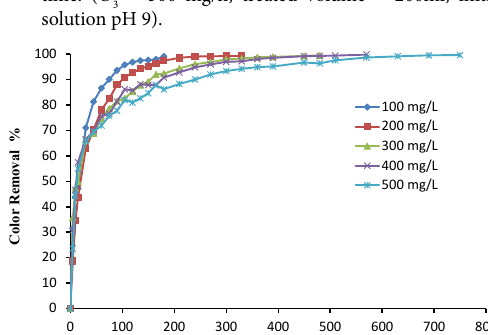
Fig. 3. Effect of Different pH (3, 5, 7, 9 and 11) on decolorization of Direct Yellow 12 at first 30 minutes, (Dye concentration = 500 mg/h, treated volume = 200 ml). = 100 mg/l, O 3